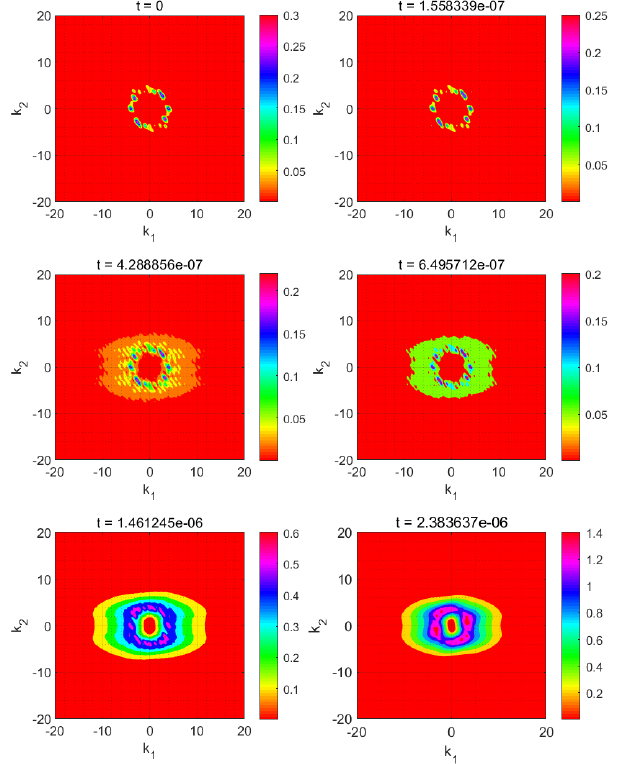
Figure 7. Simulated light scattering patterns obtained from the calculated structure factors for the case where D = 10 5 , c o* = 0.2 and T * = 0.29. The asterisks were left out of the variables k 1 , k 2 , and t in the figure.